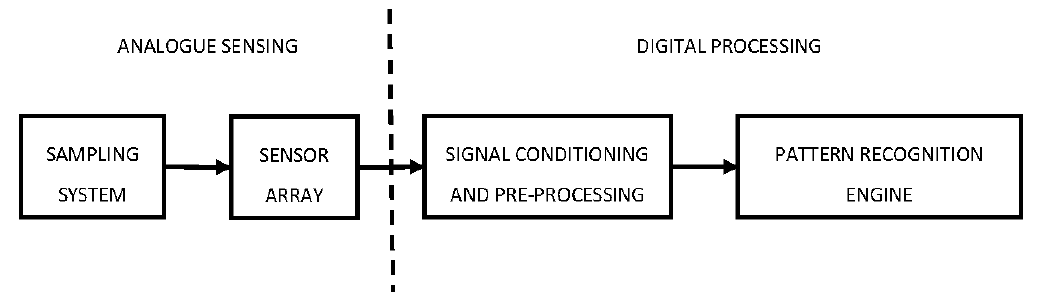
Figure 1. Key components of an e-nose system.